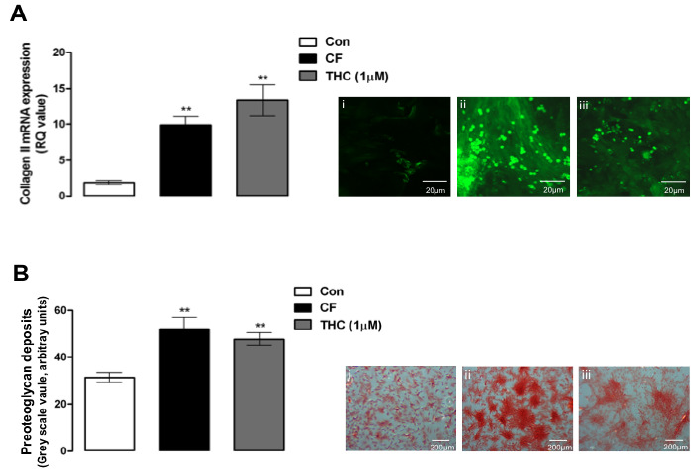
Figure 3. ∆ 9 -THC enhances MSC chondrogenesis. A, chondrogenic factors (CF) induced